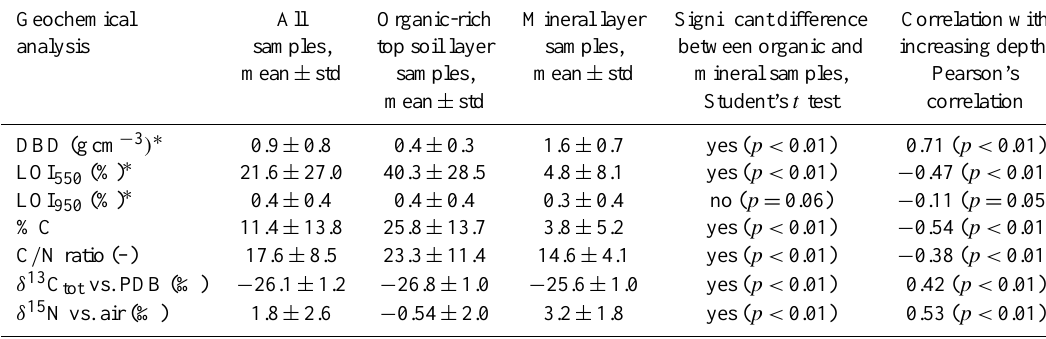
Table 2. Statistics of the geochemical analyses of soil samples. Geochemical All Organic-rich Mineral layer Significant difference Correlation with analysis samples, top soil layer samples, between organic and increasing depth, mean ± std samples, mean ± std mineral samples, Pearson’s mean ± std Student’s t test correlation DBD (gcm − 3 ) ∗